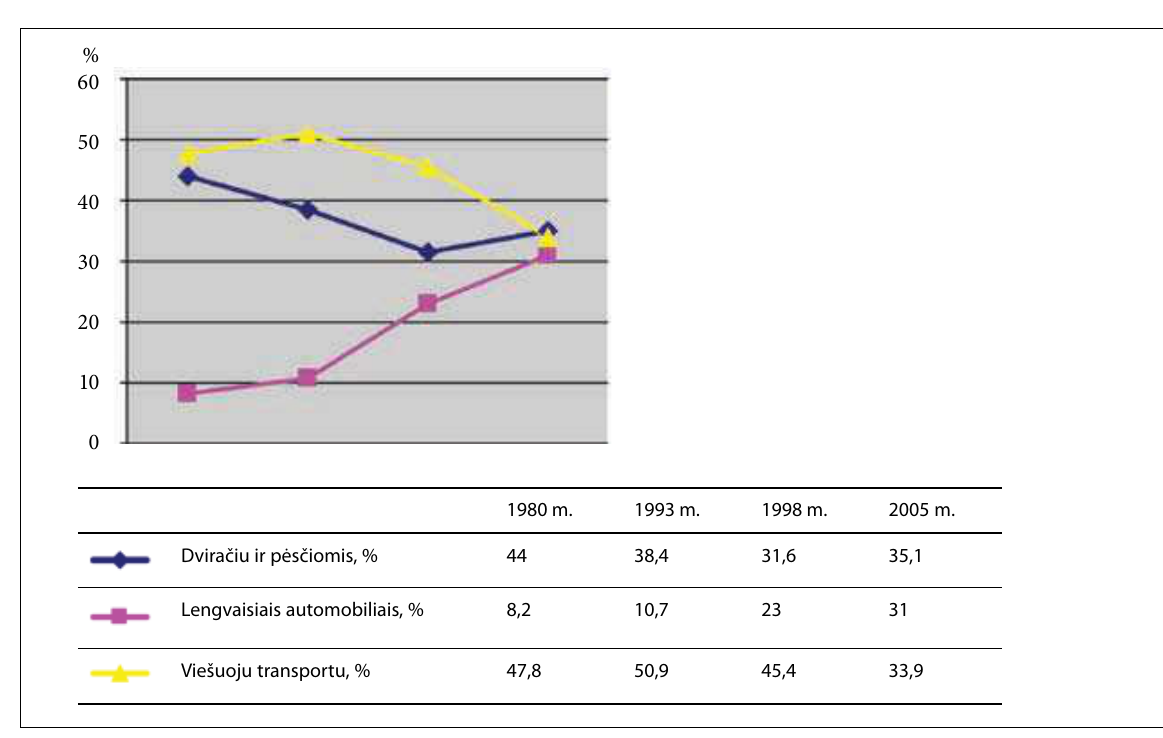
Table 1. changes in modal split of mobility in Vilnius city 1980–2005 (Vilnius city Municipality ... 2006)